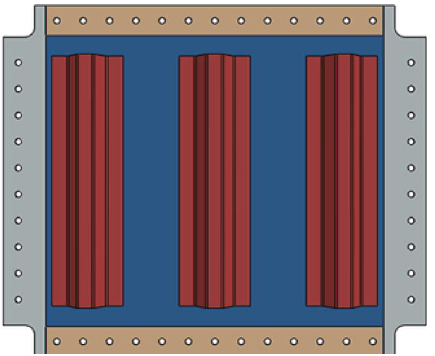
Figure 2: The simpli fi ed post-cap-reinforced composite wall panel structure.